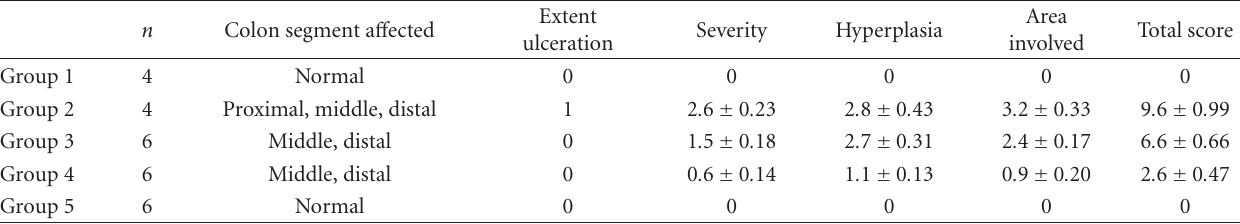
Table 1: Histological scores for the colorectal lesions observed in five experimental mice groups. Data are expressed as mean ± standard